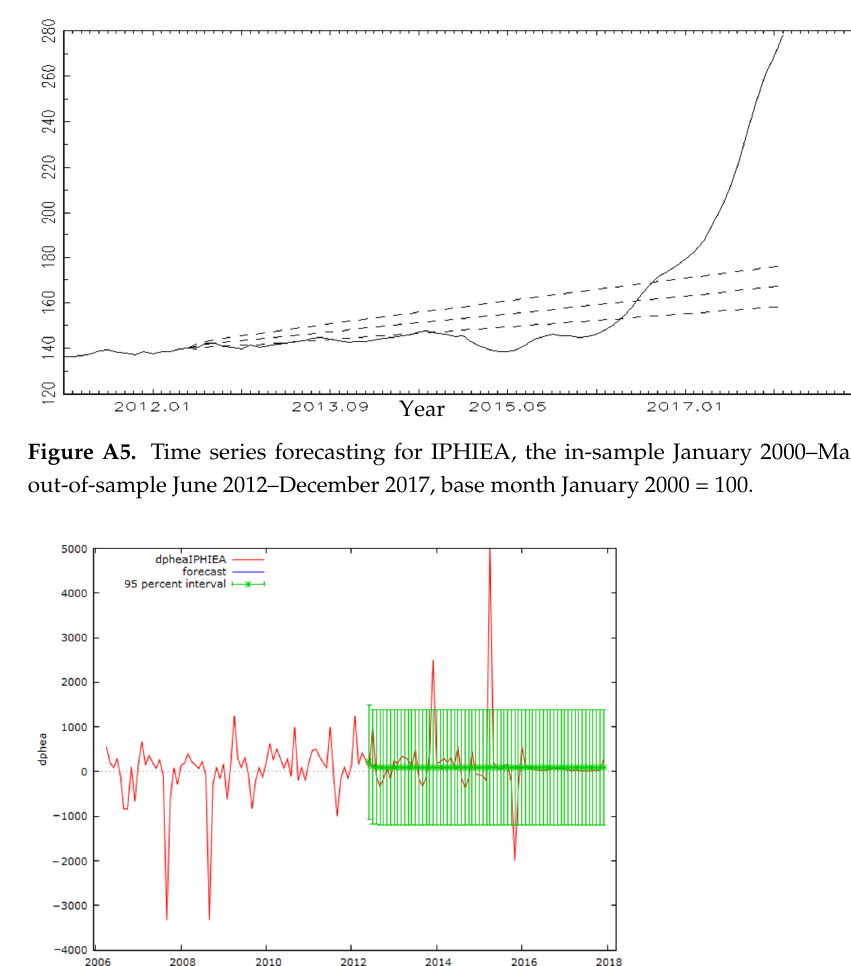
Figure A7. Time series forecasting for IPHI, the in-sample January 2000–May 2012, and the out-of- sample June 2012–December 2017, base month January 2000 = 100. Figure A8. Time series forecasting for rph, the in-sample January 2000–May 2012, and the out-of- sample June 2012–December 2017, base month January 2000 = 100. Year